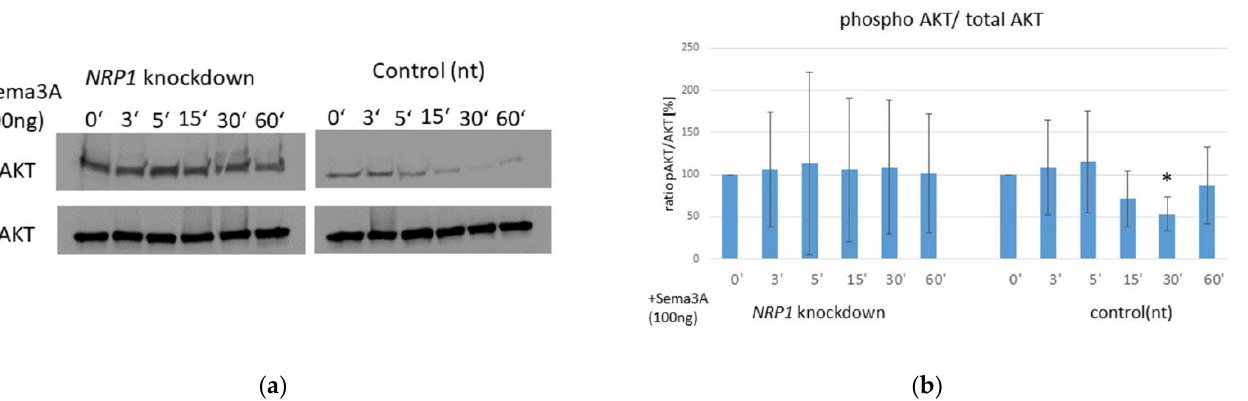
Figure 6. Sema3A stimulation leads to a decrease in AKT phosphorylation in OA chondrocytes. ( a ) Representative Western blot of phospho-AKT (pAKT) and total-AKT (AKT) protein after stimula- tion of NRP1 knockdown and control cells (nt) with 100 ng/mL Sema3A for 0, 3, 5, 15, 30 and 60 min. ( b ) Relative protein expression of pAKT and AKT was determined densitometrically. The relative ratio of pAKT/total-AKT is shown; One sample t-test, n = 4, * p ≤ 0.05. In contrast, the phosphorylation status of ERK remained unaltered in both groups after Sema3A stimulation. The pERK/ERK ratio increased in both cell groups to the same extent during 60 min of Sema3A treatment (Supplementary Figure S2). Hence, the phosphorylation of ERK is presumably not linked to the Sema3A/Nrp-1 signaling axis in OA